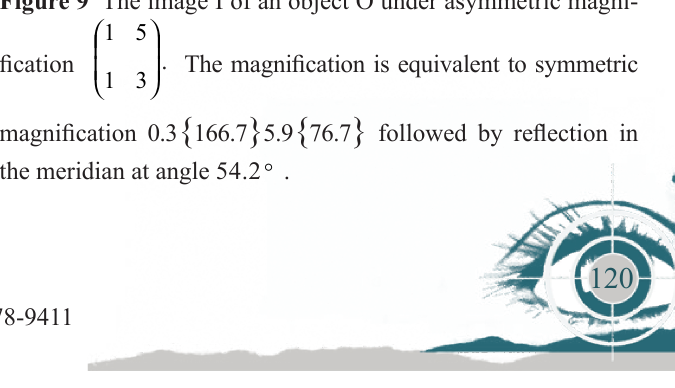
Figure 9 The image I of an object O under asymmetric magni